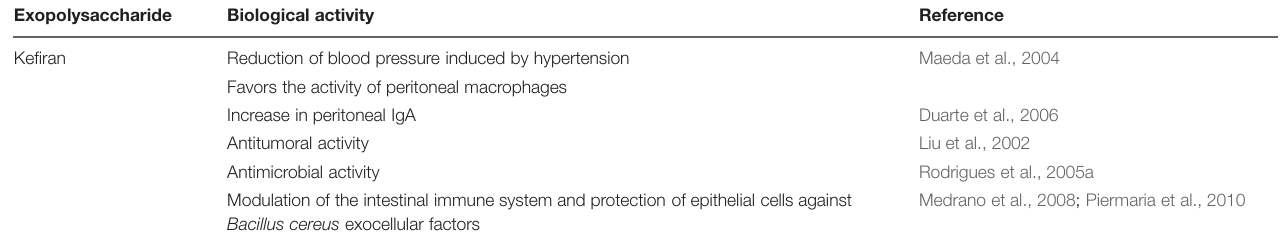
TABLE 3 | Biological activity of